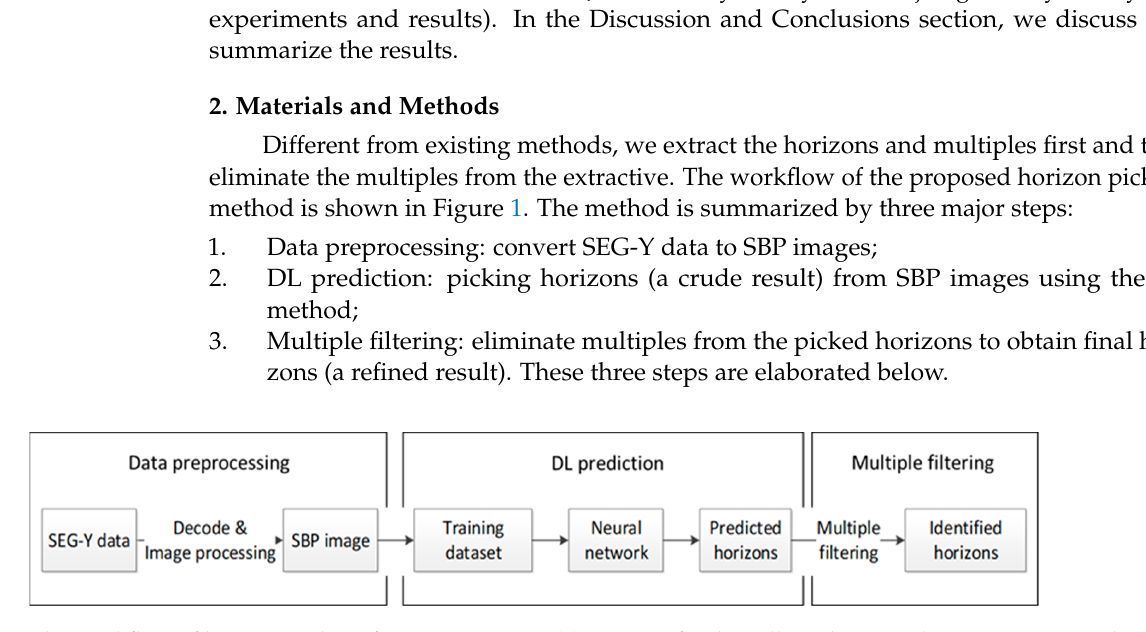
Figure 1. The workflow of horizon picking from SBP images. (1) We transfer the collected SEG-Y data to SBP images by data decoding and image processing. (2) We generate a training dataset using SBP images and utilize the dataset to train a neural network. (3) We employ the trained network to predict horizons from observed SBP images, which we exclude from the training dataset. (4) We eliminate the multiples from the prediction using the proposed multiple filtering method and obtain the final horizons.